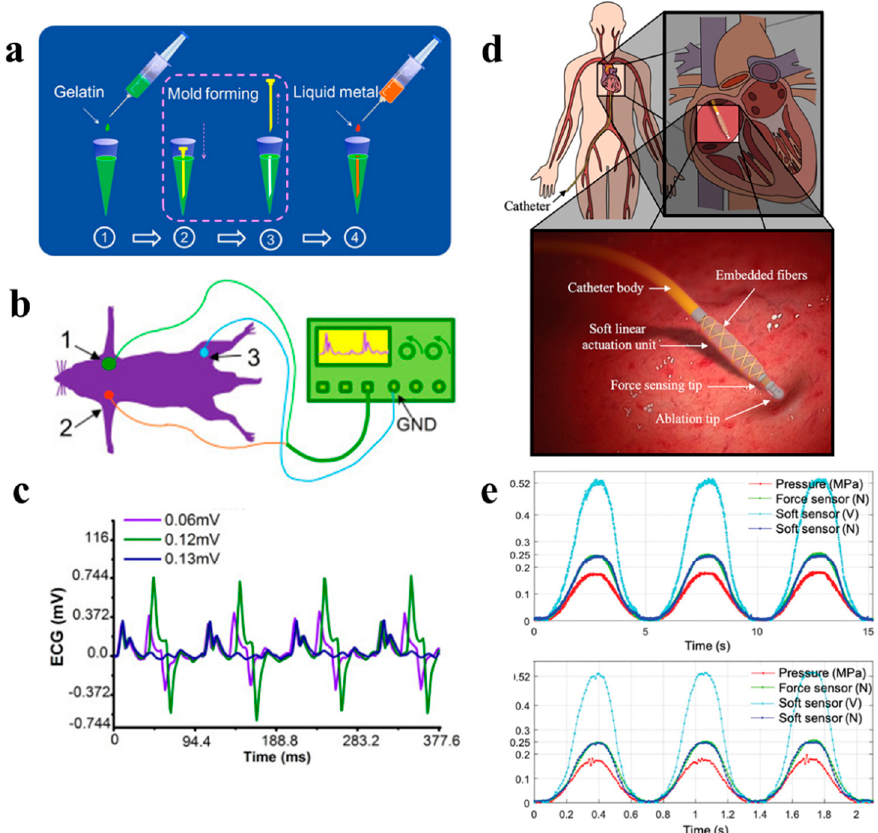
Figure 12. Implantable medical devices. ( a ) Alternative strategies for making implantable bio-electrode through directly injecting liquid metal and allied packaging material inside a pipette tip; ( b ) Schematics of in vivo experiment for measuring the mouse ECG signal using the injected electrode. ( c ) The recorded ECG signals of experimental mouse undergoing a 10 Hz electrical stimulation with different voltages [121]. Copyright (2019) Springer Nature. ( d ) Conceptual design of a cardiac ablation catheter integrated with soft actuation and sensing unit for dynamic force control. ( e ) The soft sensor response to sinusoidal input for dynamic characterization at 0.2 Hz and 1.5 Hz [122]. Copyright (2019) by the authors.